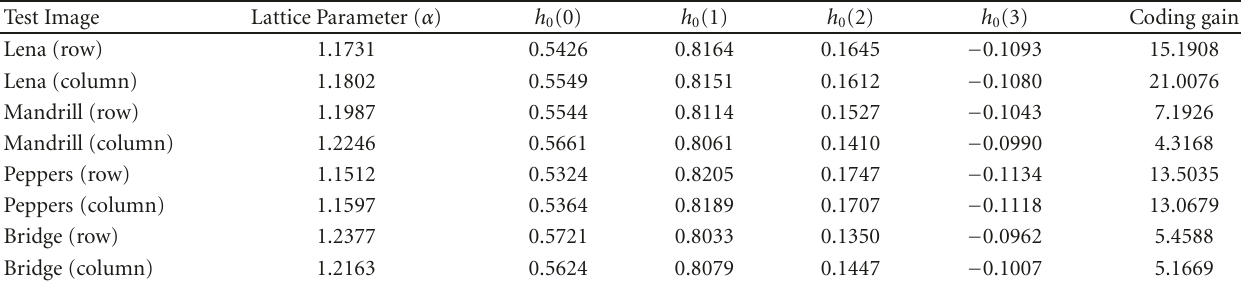
Table 2: Lattice parameters of the test images and the corresponding low-pass filter coe ffi cients and coding gains.